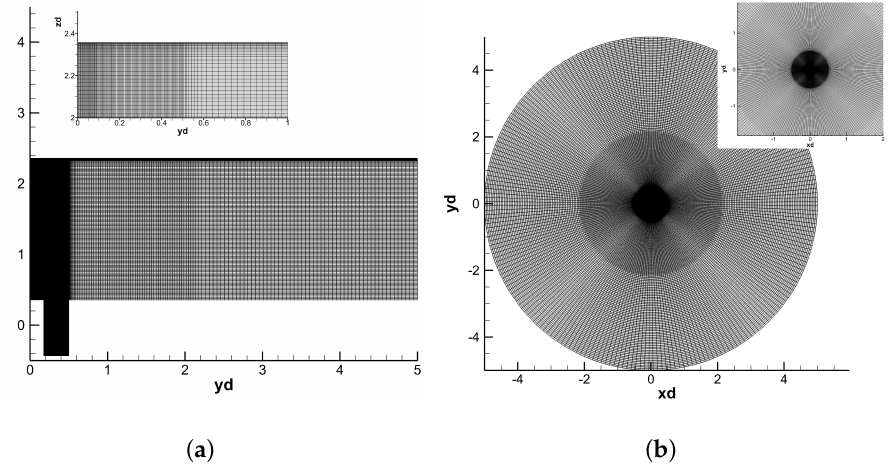
Figure 5. Mesh details used for calculation (sample H = 2) ( a ) Mesh in the r − z central plane. ( b ) Mesh in the target